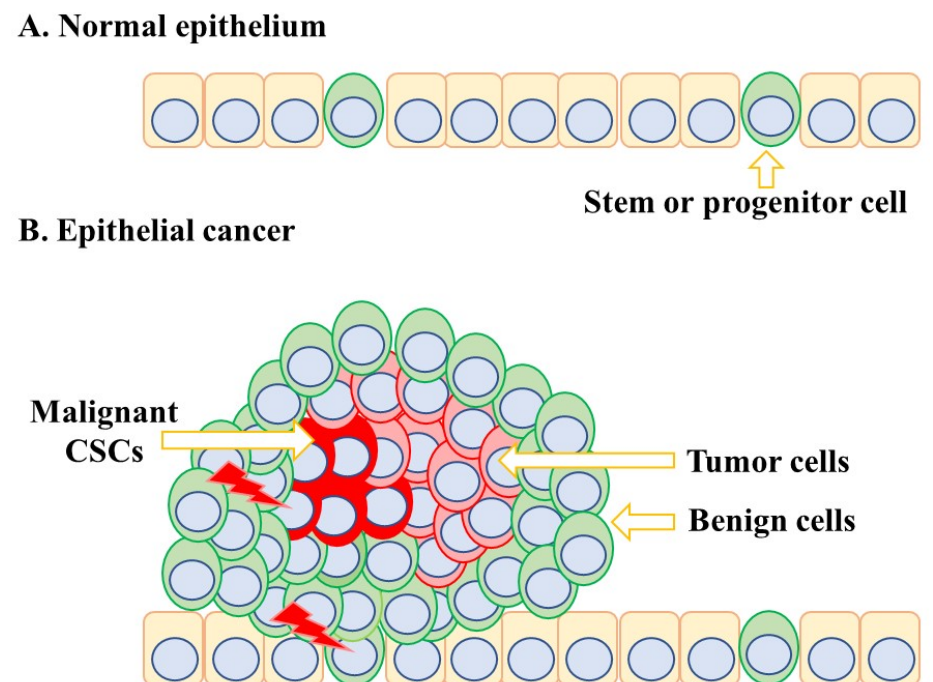
Figure 4. Normal epithelial stem cells and carcinoma stem cells reside in different environments. Normal epithelial stem cells are scattered and intermittent throughout the normal epithelium. A proposal regarding epithelial carcinoma is that a first oncogenic insult leads to a benign and homogeneous population of cells, with a second oncogenic insult giving rise to a malignant and invasive clone. CSCs overtake the tumour after a final hit.